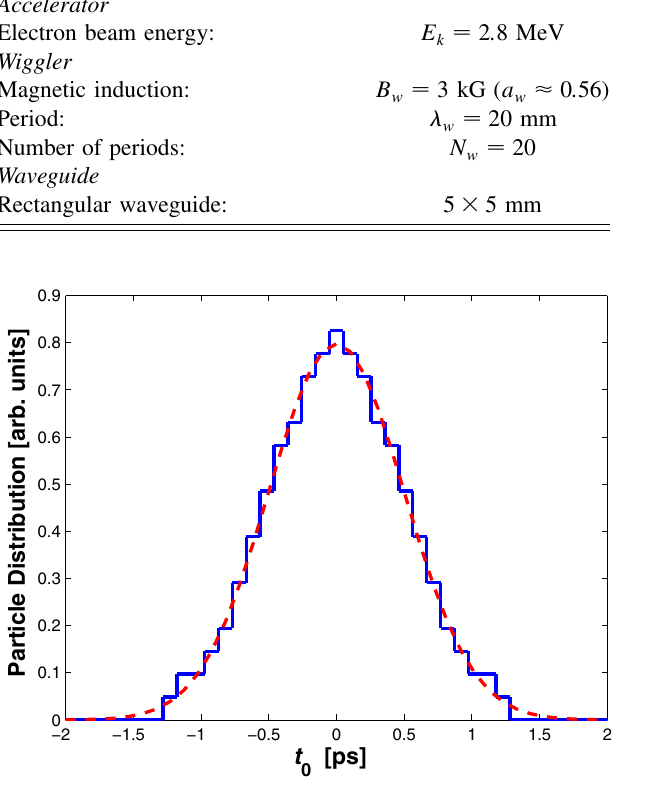
FIG. 2. (Color) Initial time distribution of N (cid:4) 201 charged particles in the simulations (bunch duration is T dashed line shows the respective Gaussian distribution function (30).